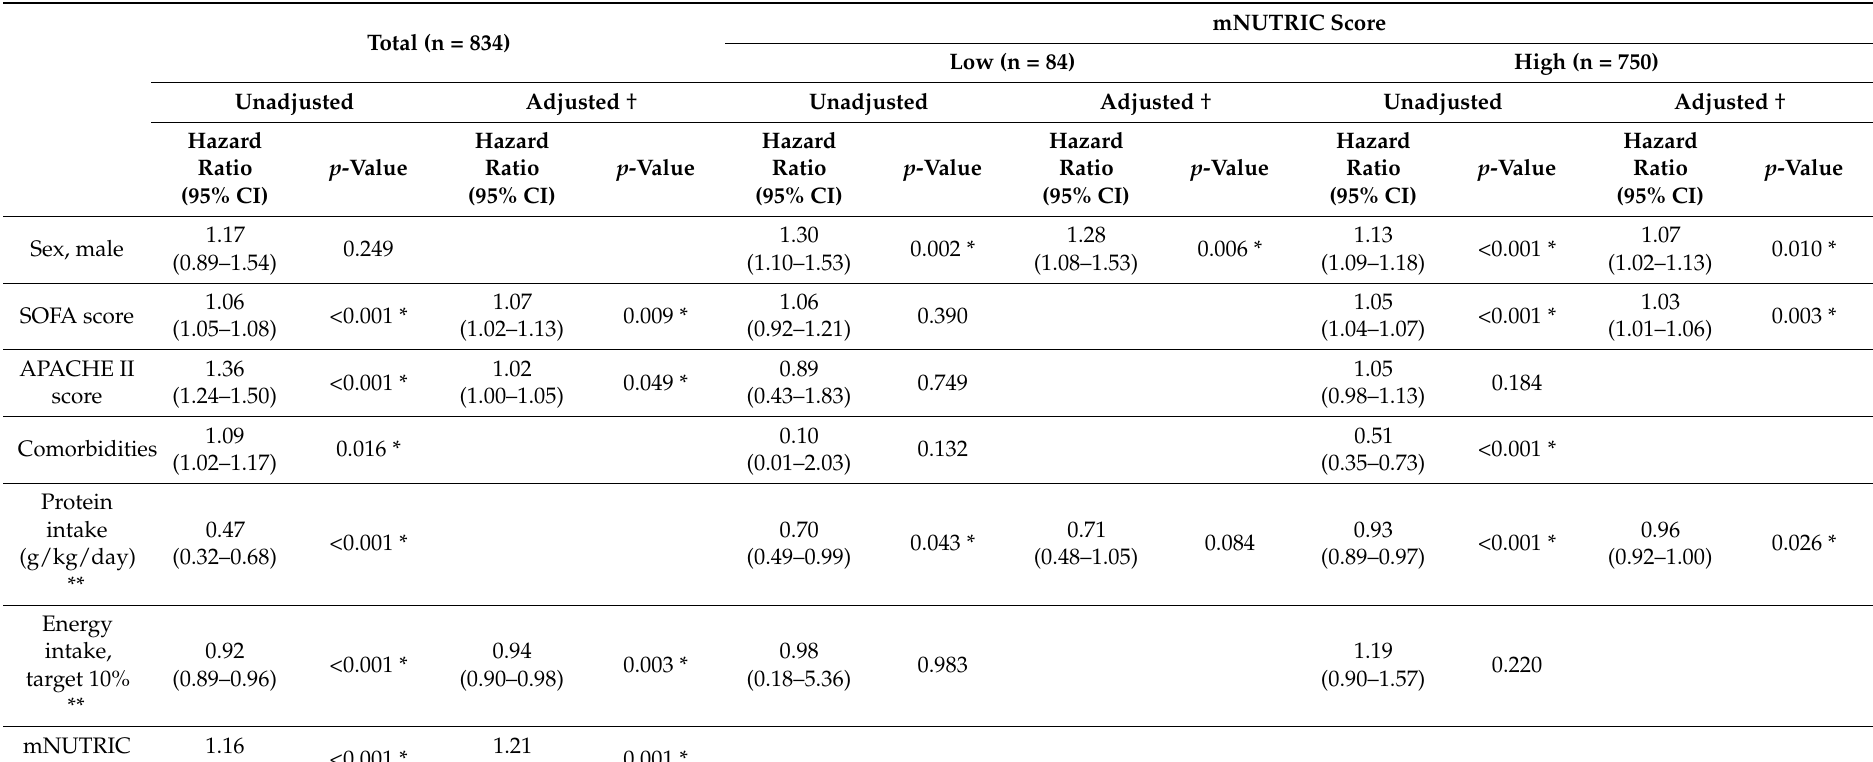
Table 3. Association between 30-day mortality and nutrition supply one week after sepsis or septic shock